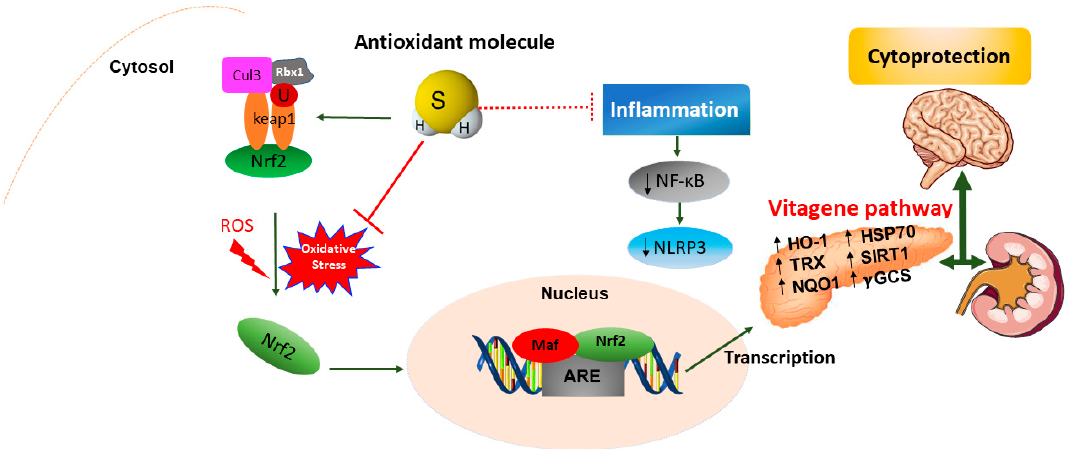
Figure 3. The modulation of the Nrf2-vitagene pathway by H 2 S. In physiological conditions, Nrf2 is bound to its inhibitor Keap1 and is restricted to the cytosol where it undergoes ubiquitination and proteasomal degradation via association with the Cul3-Rbx1-based E3 / ubiquitin ligase complex. Under stress conditions, Nrf2 is released from Keap1 and is translocated into the nucleus where it binds to the phase 2 of ARE in heterodimeric combination with the Maf transcription factor in the DNA promoter region. The H 2 S antioxidant molecule blocks oxidative stress and NLRP3 inflammasome cascade by activating Nrf2 nuclear translocation and the transcription of cytoprotective (phase 2) vitagenes. The upregulation of the vitagene pathway such as HO-1, Hsp70, Trx, sirtuin Sirt1, NQO1, and γ -GCS improves brain health in neurological disorders. Nuclear factor-erythroid 2 p45-related factor 2 (Nrf2), Kelch-like ECH-associated protein 1 (Keap1), antioxidant response element (ARE), heme-oxygenase 1 (HO-1), heat shock protein 70 (Hsp70), thioredoxin (Trx), sirtuin 1 (Sirt1), NAD(P)H: quinone oxidoreductase 1 (NQO1), γ -glutamylcysteine synthetase ( γ - GCS).